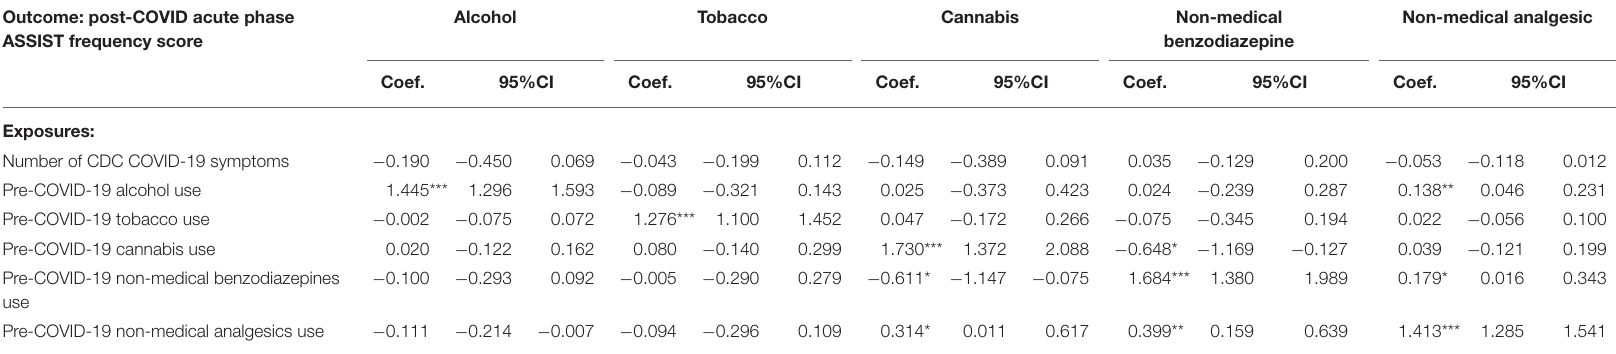
TABLE 3 | Results of the ordinal regression model for post-COVID-19 acute phase substance use among 993 individuals who had mild COVID-19 in São Caetano do Sul, SP, Brazil. Outcome: post-COVID acute phase ASSIST frequency score